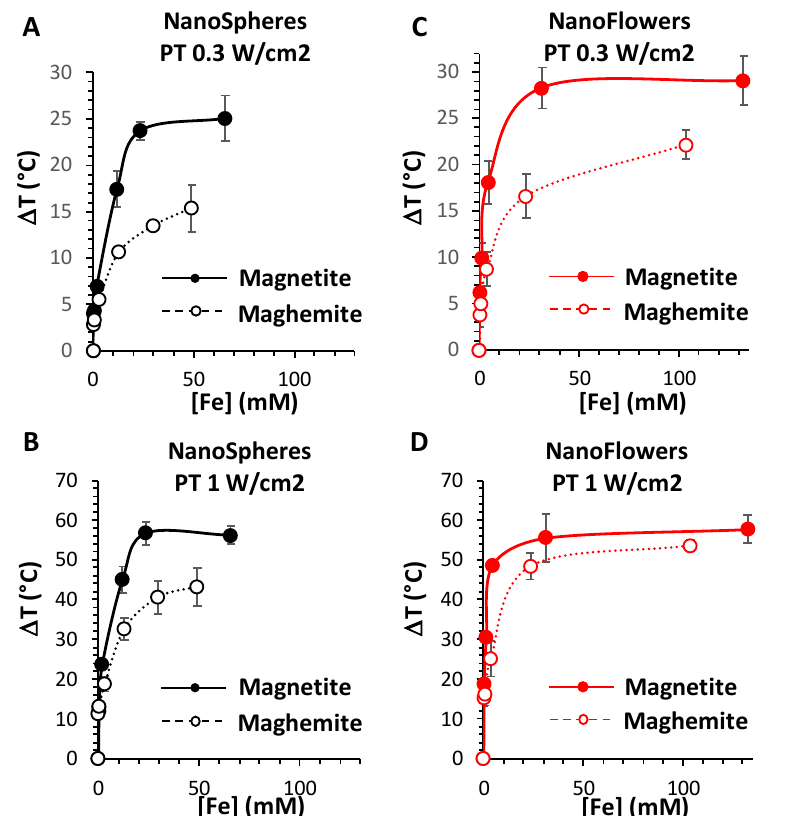
Figure 5. Analysis of the photothermal performances of the MNPs internalized within tumor cells. Temperature elevation profiles for PC3 cells treated with nanospheres ( A , B ) and nanoflowers ( C , D ) in their magnetite (full dotted lines) and maghemite (empty dotted lines) forms, irradiated with a 1064 nm laser at a power density of 0.3 W cm − 2 ( A , C ) and 1 W cm − 2 ( B , D ), as a function of the iron concentration in the cell suspensions measured afterwards by ICP analysis.